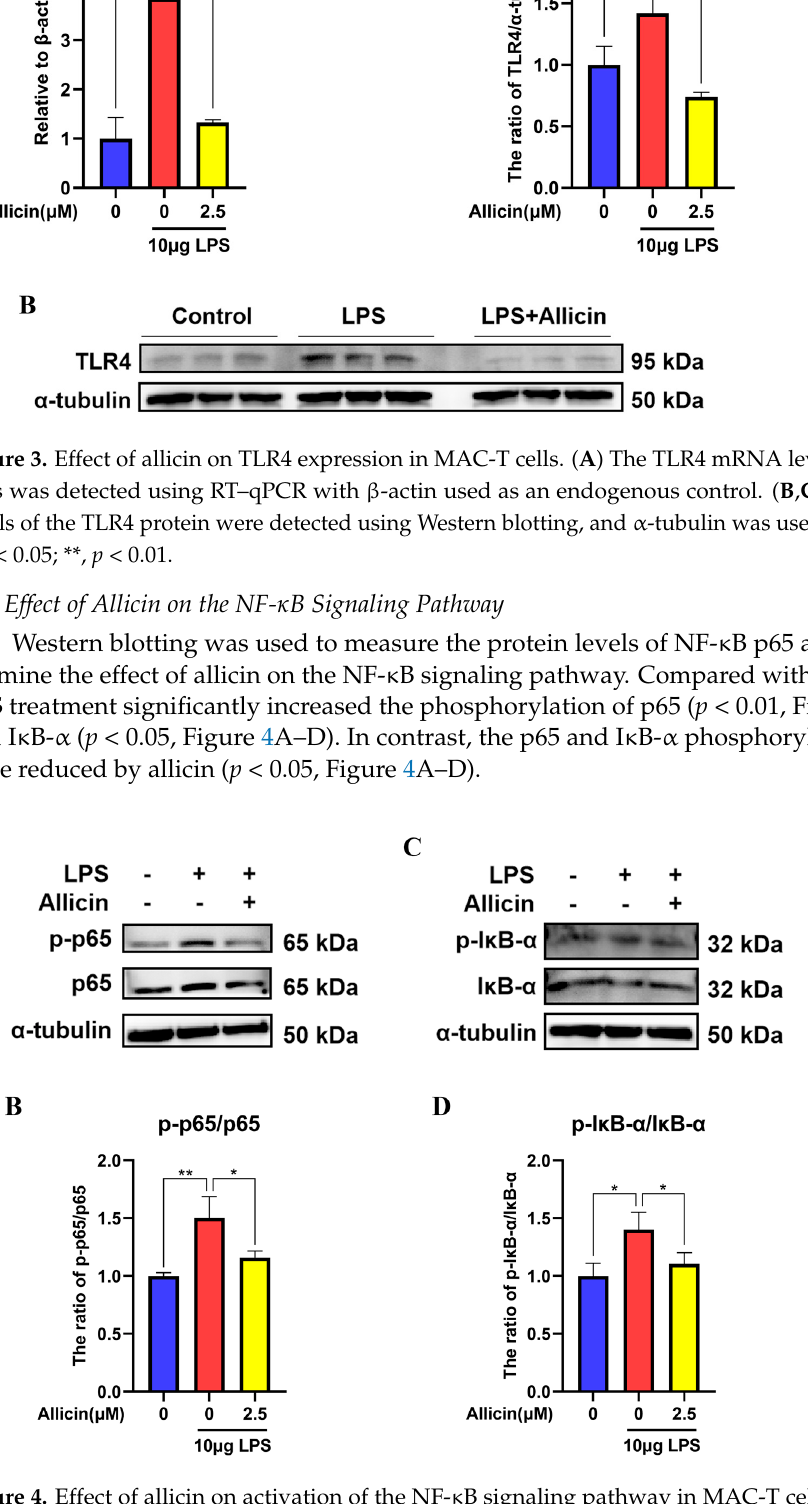
Figure 4. Effect of allicin on activation of the NF- κ B signaling pathway in MAC-T cells. ( A – D ) Ex- pression levels of p65 and I κ B- α proteins were detected using Western blotting, and α -tubulin was used as a control. *, p < 0.05; **, p <